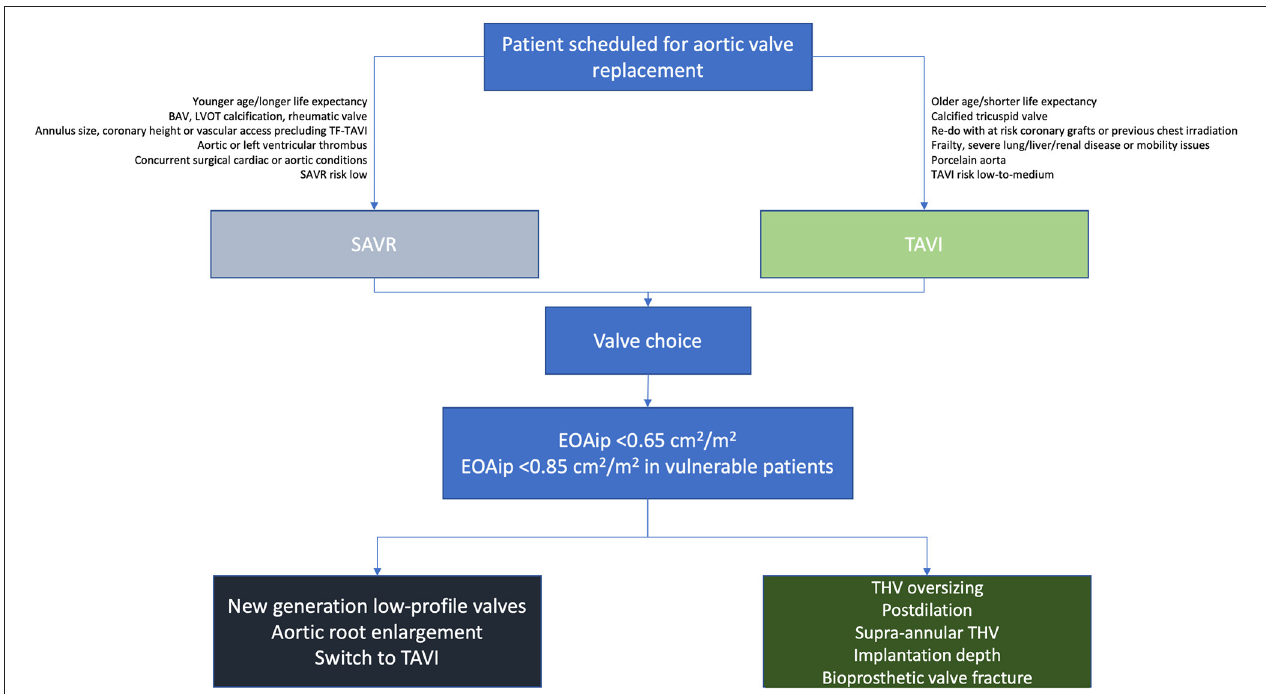
FIGURE 4 | Proposed algorithm for prevention of PPM according to chosen approach of aortic valve replacement. BAV, bicuspid aortic valve; EOAip, predicted indexed effective orifice area; LVOT, left ventricular outflow tract; TF, transfemoral; THV, transcatheter heart